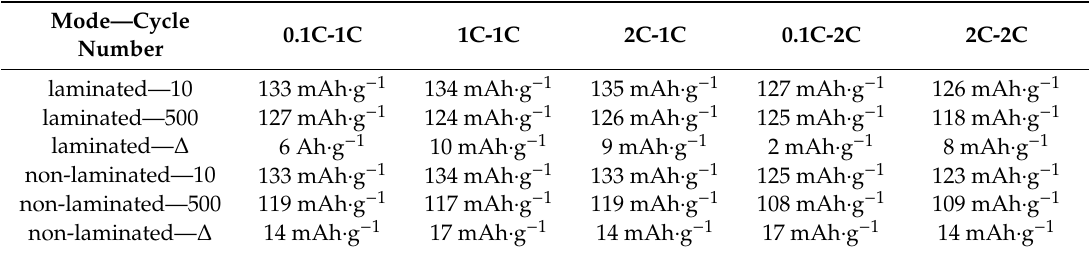
Table 1. Averaged capacity-fade of non-laminated / laminated cells at varied formation / cycling